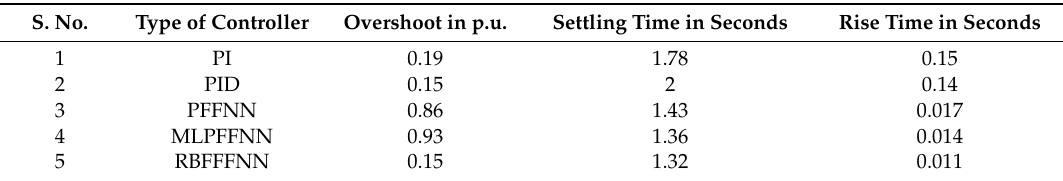
Table 5. Reactive power at rotor side.